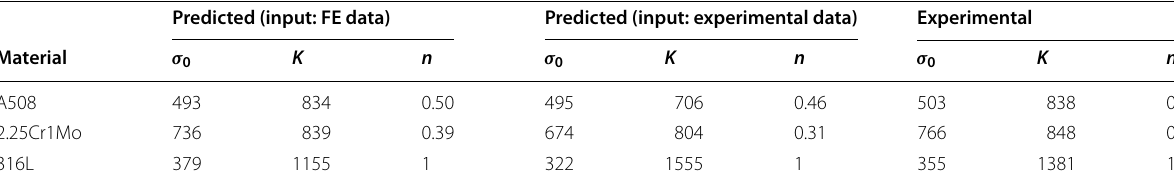
Table 3 Material parameters fitted from the stress-strain data Predicted (input: FE data) Predicted (input: experimental